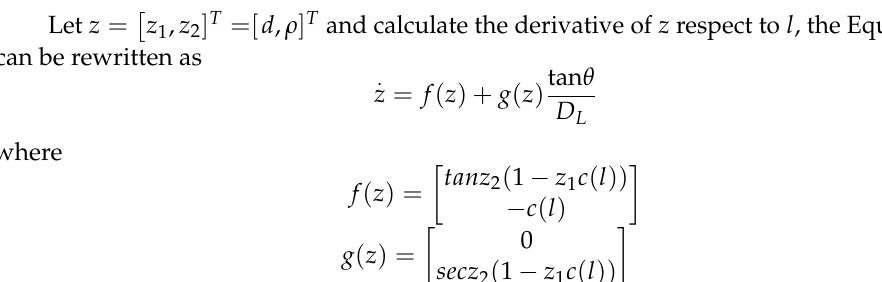
Figure 6. Kinematic model.